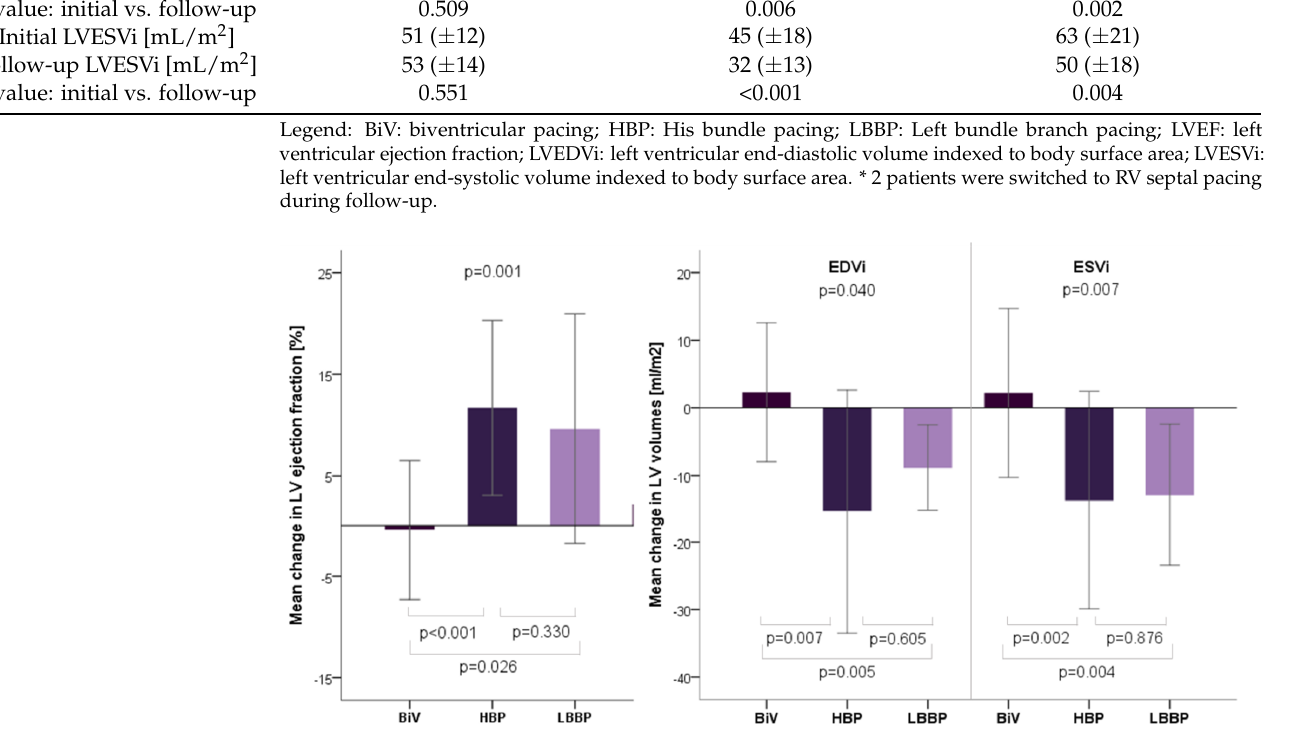
Figure 3. Comparison of mean ( ± SD) changes in echocardiographic left ventricular volumes and ejection fraction between baseline and follow-up values for all pacing modalities. Upper p value (ANOVA) determines whether differences between the means of all 3 groups are statistically signif- icant. p values comparing each two groups ( t - test) are added at the bottom. Legend: BIV: biventric- ular pacing; HBP: His bundle pacing; LBBP: left bundle branch pacing; LV: left ventricle; LVEDVi: left ventricular end-diastolic volume indexed to body surface area; LVESVi: left ventricular end- systolic volume indexed to body surface area. 4. Discussion The present study assessed different permanent pacing modalities in a subgroup of patients with HF and narrow QRS who underwent AVNA. There were two major find- ings. First, AVNA combined with CSP was feasible and safe in high percentage of patients with rate refractory AF and HF. Second, CSP was associated with superior clinical and echocardiographic improvement compared to BiV pacing. 4.1. Procedures Assessment BiV pacing is an established treatment option for patients undergoing the “pace and ablate” strategy [6–8]. Recently reported high acute success rates of HBP and LBBP made these two modalities a potential alternative to BiV [24]. In the line with these reports, the present study demonstrated successful permanent CSP pacemaker implantation com- bined with AVNA in all enrolled patients. However, there are several hesitations that limit wider clinical application of CSP in routine clinical practice. Especially HBP is related to technical challenges with prolonged learning curve, longer fluoroscopy duration, higher and unstable capture thresholds with early battery depletion [11,25]. Recently published meta-analysis have demonstrated that LBBP might overcome these deficiencies [25]. In